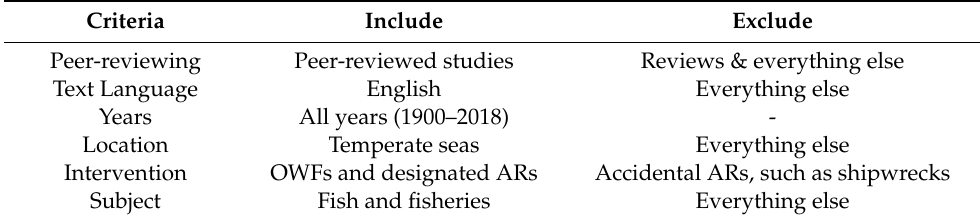
Table 2. Inclusion and exclusion criteria for the systematic